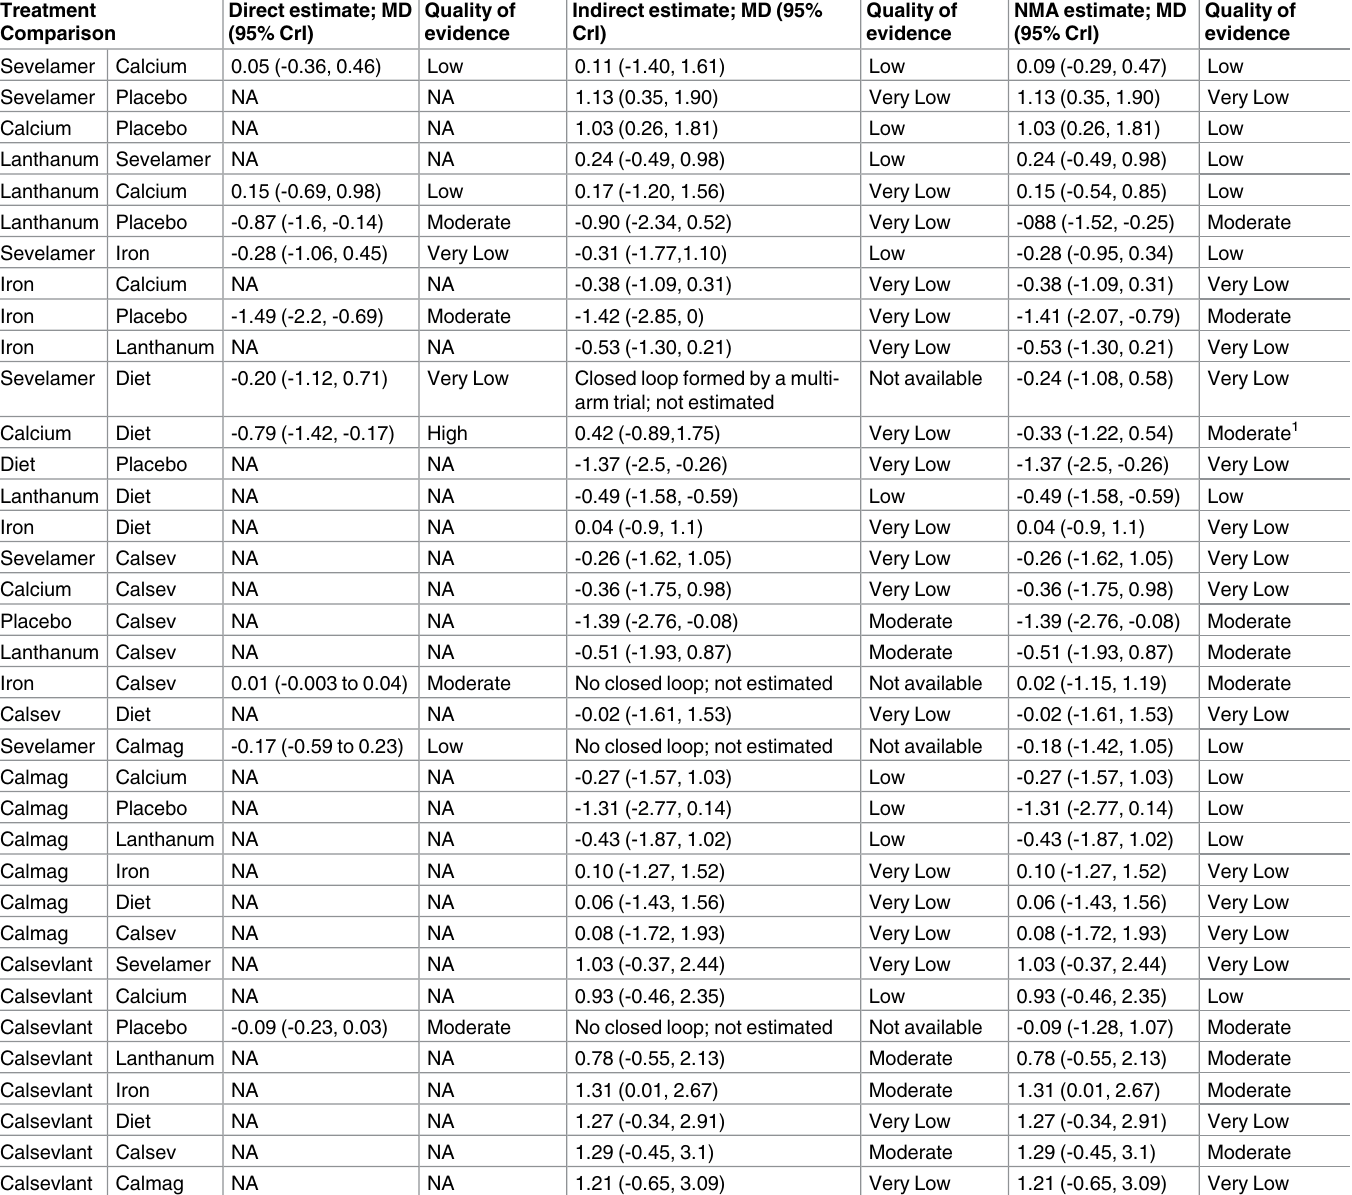
Table 1. Direct, indirect, and NMA estimatesof phosphate with 95% credible intervals and GRADE assessments from each pairwise comparison within the phosphate-binder network. Treatment